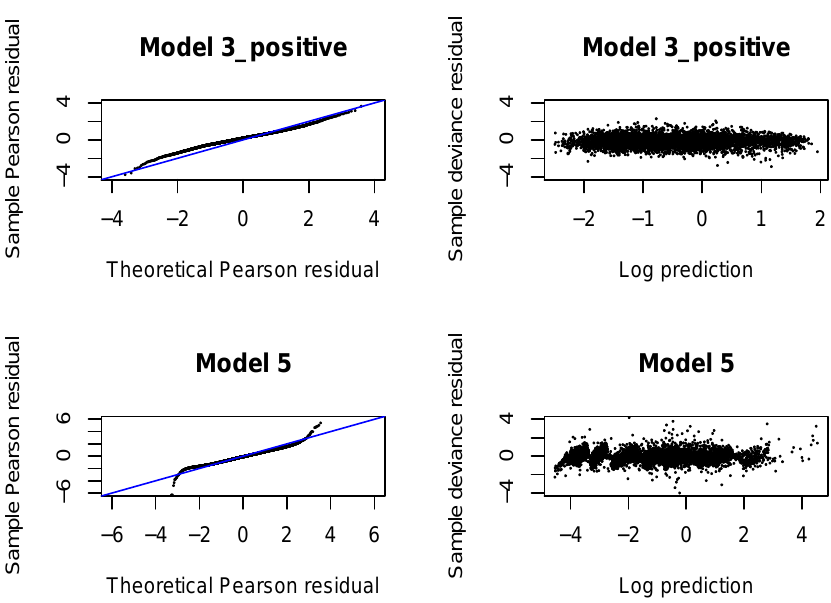
Figure A8. QQ normal plots and Tukey-Anscombe plots in Models 3_positive and 5 fitted with neural